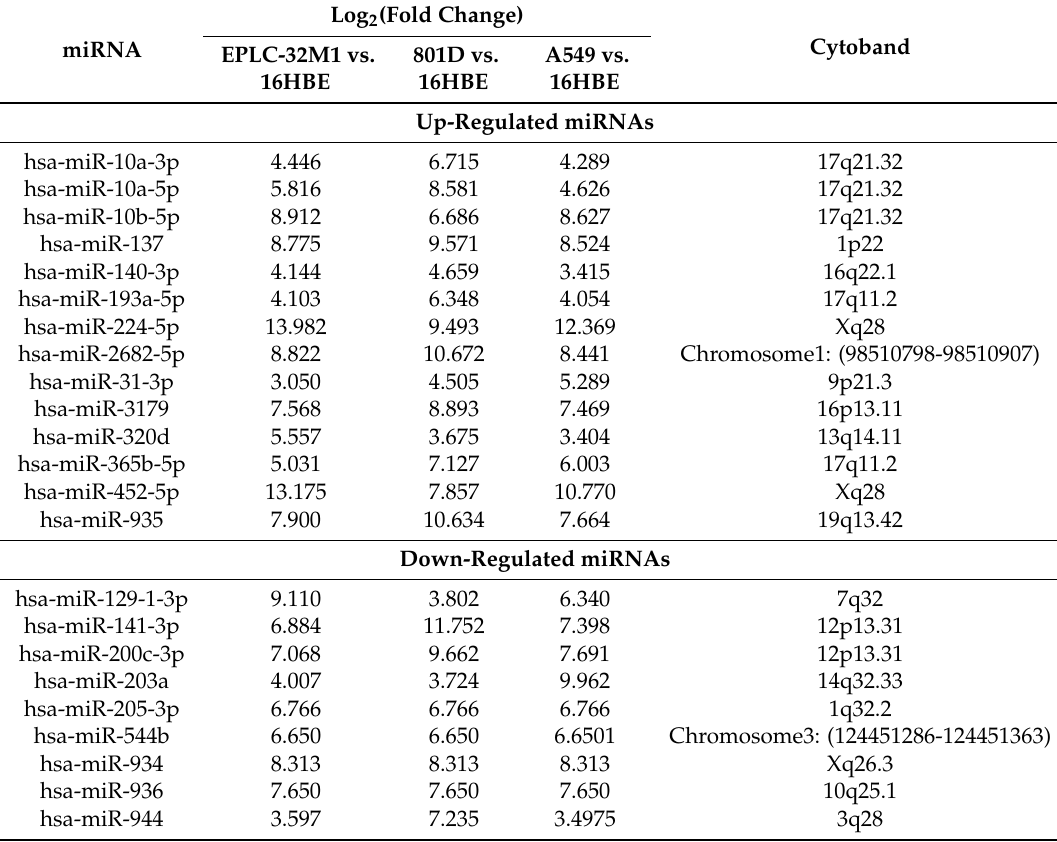
Table 1. Most dyregulated microRNAs (miRNAs) in non-small cell lung cancer (NSCLC) cells compared with the normal cell 16HBE. (Log 2 (Fold change) > 3, p < 0.001). miRNA